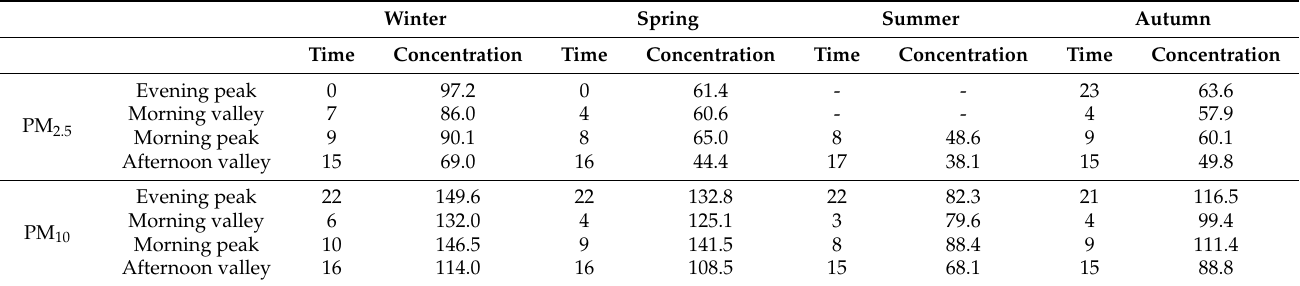
Table 3. Time (hour) and concentration ( µ g · m − 3 ) of peak and valley concentrations of PM 2.5 and PM 10